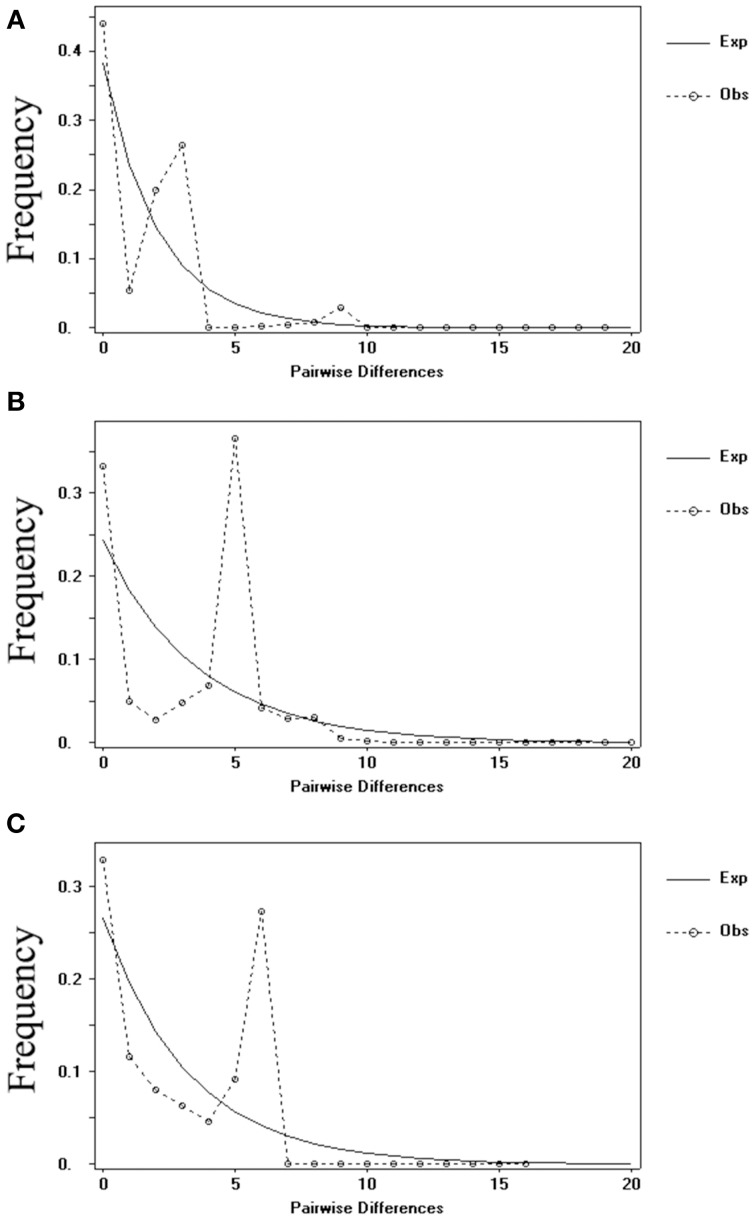
Distribution of the number of pairwise nucleotide differences for cpDNA sequence (A) and nDNA SmHP (B), RPB1 (C) sequences data in C. diannanensis. The solid line stands for expected values and the dashed line represents observed values under a model of sudden population expansion.